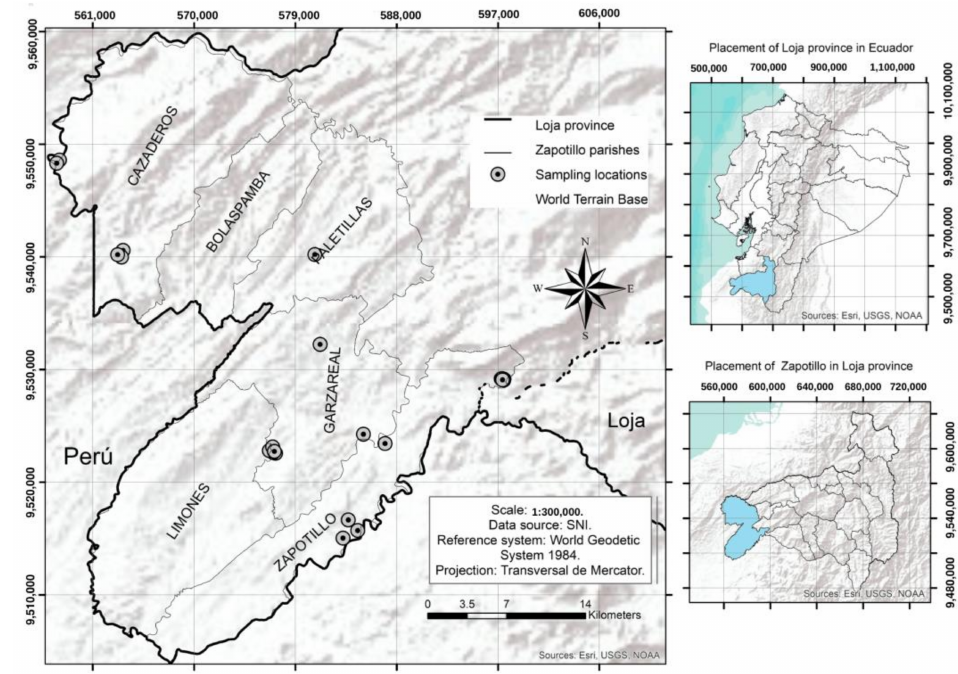
Figure 1. Sampling locations in parishes from Zapotillo Canton,